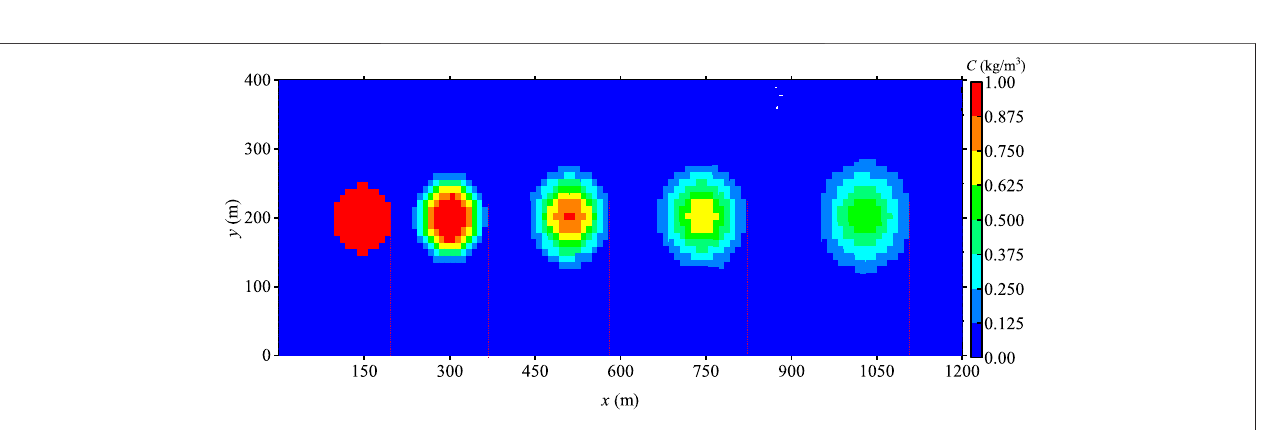
Frontiers in Environmental Science |